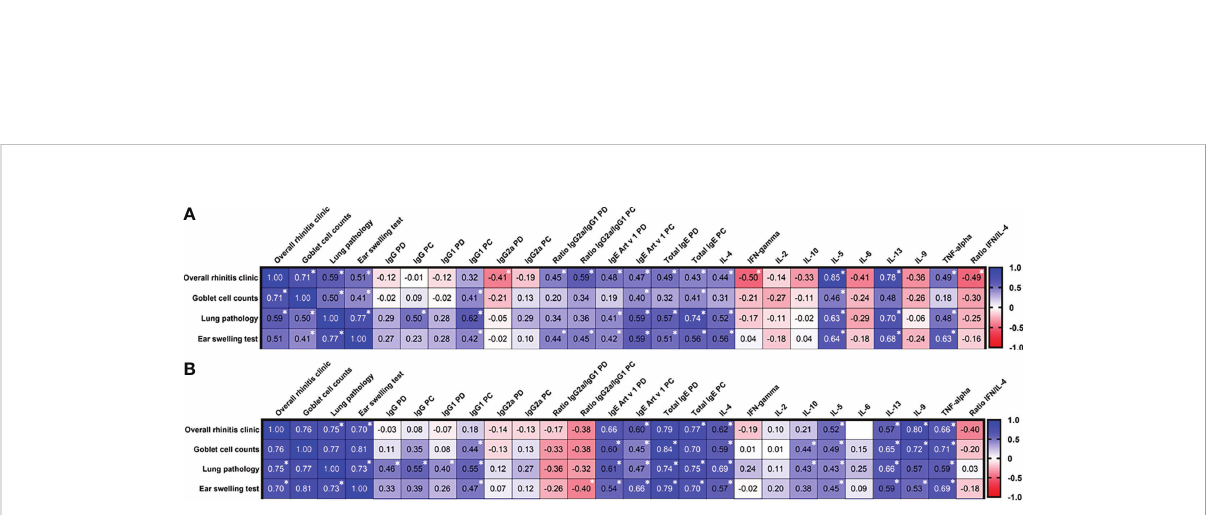
FIGURE 6 Correlation matrix analysis between allergic rhinitis and bronchial asthma signs and humoral and cellular immune variables after pre- (A) and co-seasonal (B) ASIT regimens and challenge. The color refers to the r value scale (from -1 to 1) shown on the right. The number in each cell represents the actual r value. The analysis was performed using Pearson ’ s multivariate correlation method. Normalized data were used for this analysis. PD – post desensitization, PC – post challenge. *P <0.05.